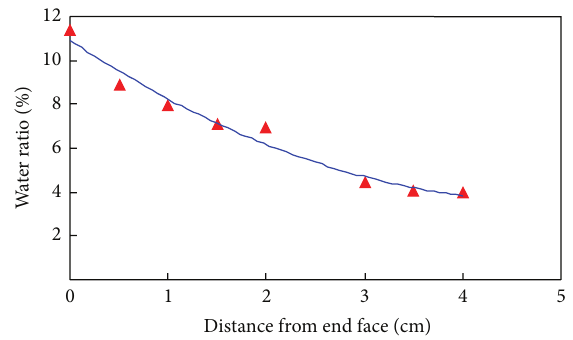
Figure 2: Experimental results of water diffusion in